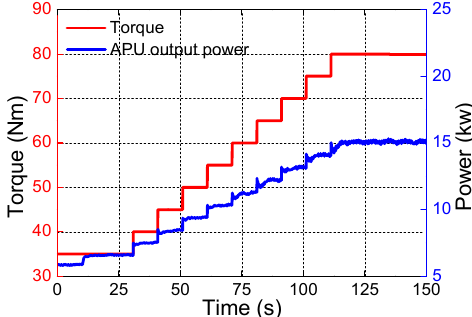
Figure 21. APU power regulation curve.